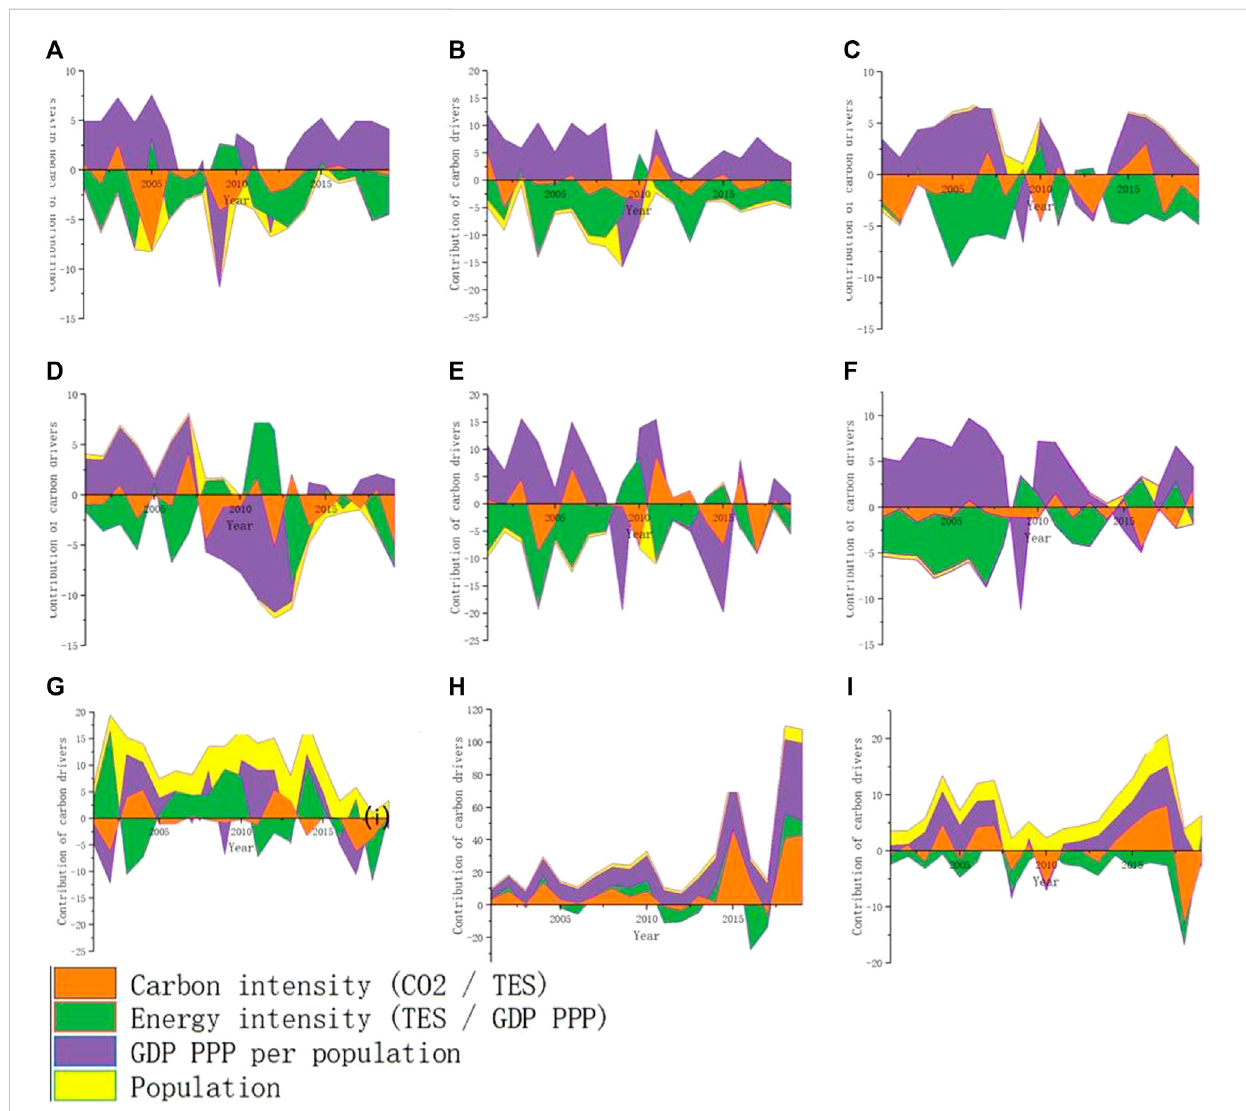
Decomposition results of driving factors for carbon emission changes in nine countries. (A) Hungary; (B) Romania; (C) Czech Republic; (D) Greece; (E) Ukraine; (F) Russian Federation; (G) Saudi Arabia; (H) Pakistan. (I)